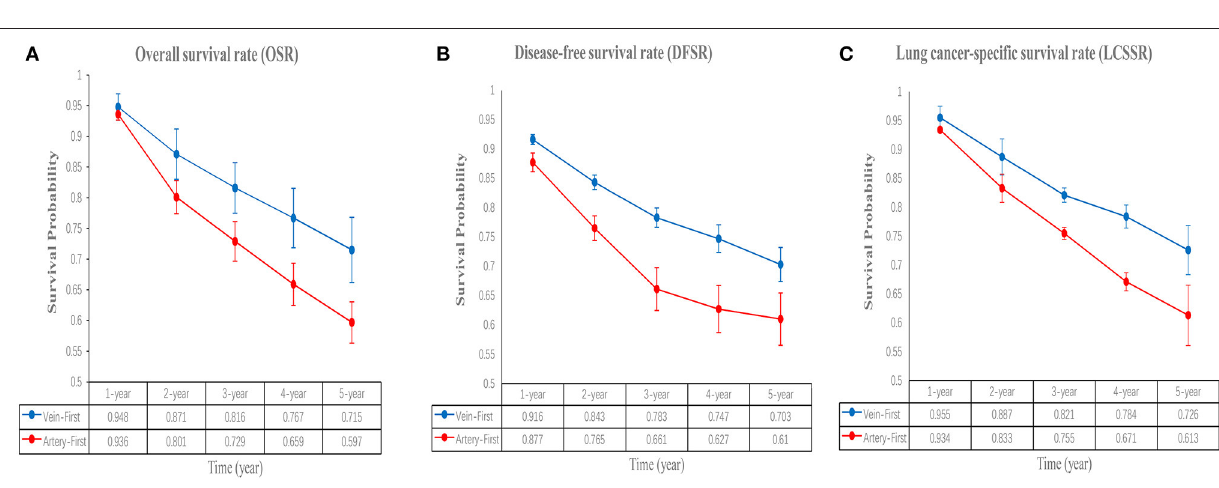
medium quality, and six studies (7, 10–13) were of high quality ( Supplementary Table 3 ). The baseline characteristics are listed in Table 1. According to the GRADE system, ( Supplementary Table 4